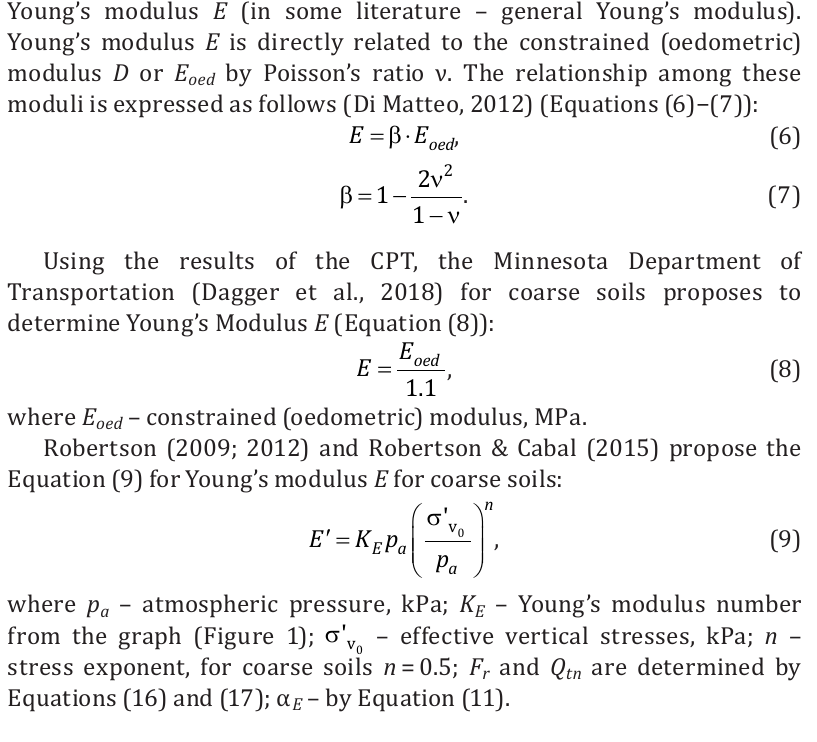
Note: 1 – sensitive, fine-grained; 2 – organic soils – clay; 3 – clay – silty clay to clay; 4 – silt mixtures – clayey silt to silty clay; 5 – sand mixtures – silty sand to sandy silt; 6 – sands – clean sand to silty sand; 7 – gravelly sand to dense sand; 8 – very stiff sand to clayey sand; 9 – very stiff,